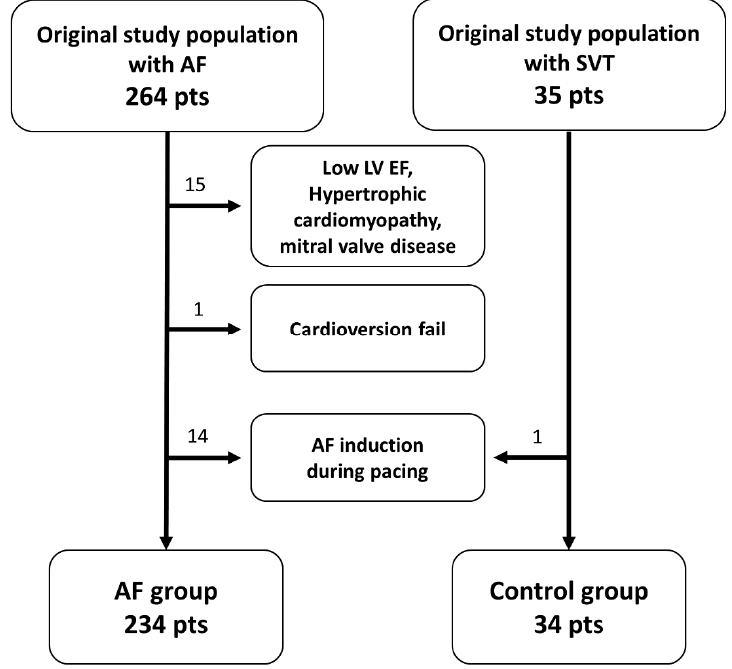
Figure 1. The diagram demonstrates patient enrollment and disposition during the study; AF, atrial fibrillation; SVT, supraventricular tachycardia; LV, left ventricular; EF, ejection fraction.